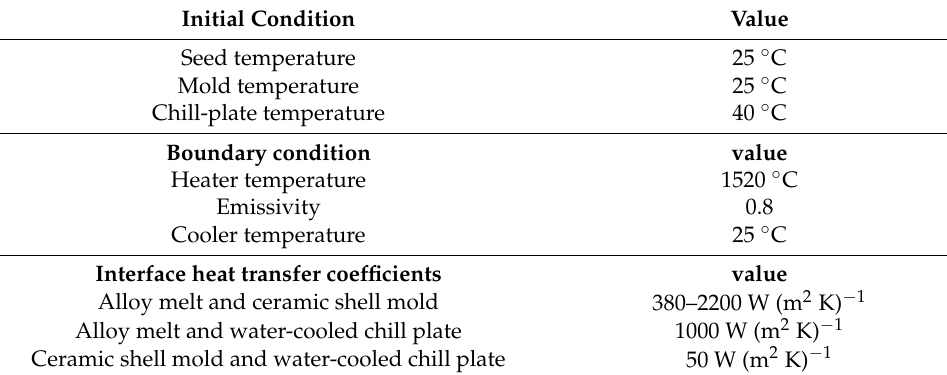
Figure 1. FEM mesh model of the casting system: ( a ) the whole model, ( b ) a partial sectional view of the assembly marked by the red frame. Table 2. Model parameters for solidification